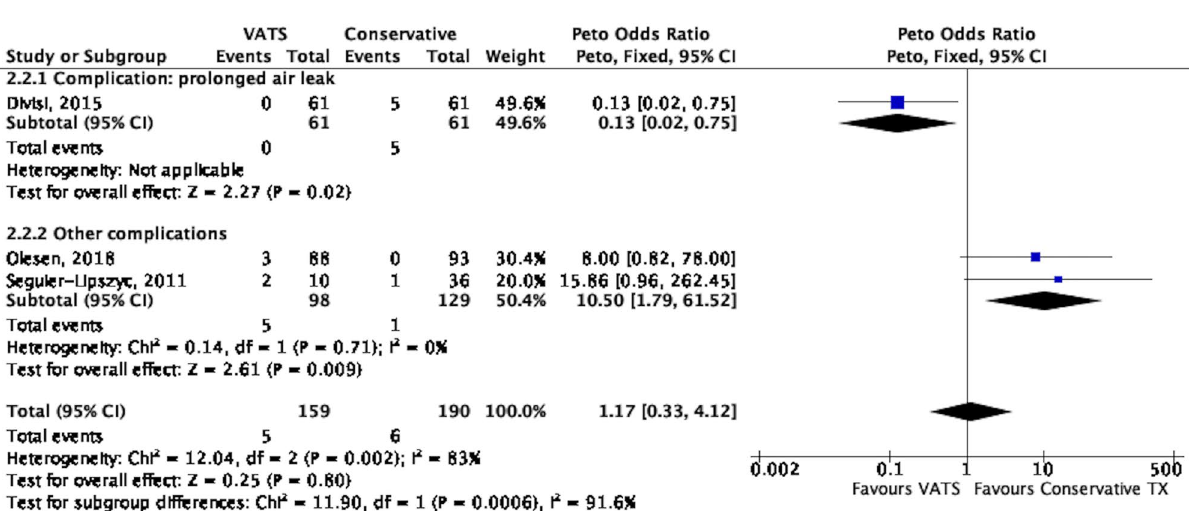
Figure 3. Forest plot of the comparison of complication rate between VATS and conservative